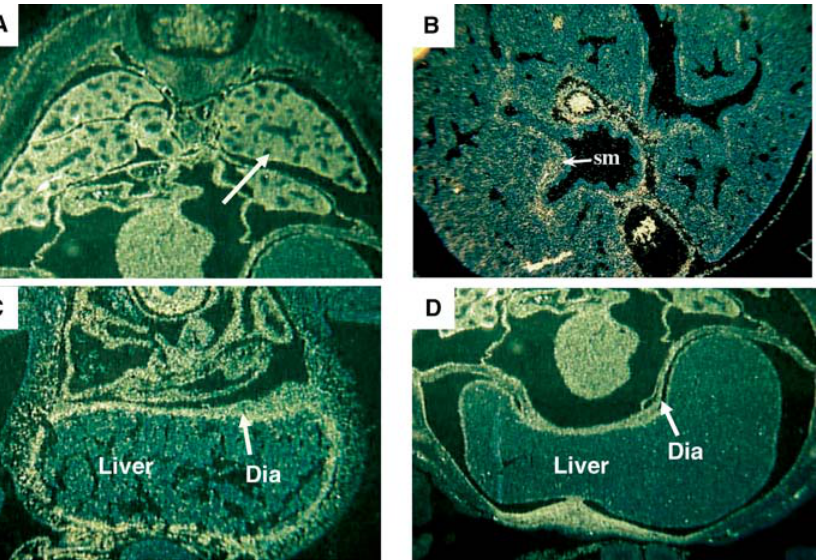
Figure 3. Fog2 Is Expressed in the Developing Lung and Diaphragm Fog2 is expressed in the diffuse pulmonary mesenchyme at E13.5 (A) (arrow shows mesenchyme) and is restricted to the bronchial and vascular smooth muscle (sm) at E16.5 (B). Fog2 is expressed diffusely in the developing diaphragm (Dia) both prior to (E11.5) (C) and after muscularization (E13.5) (D). DOI: 10.1371/journal.pgen.0010010.g003